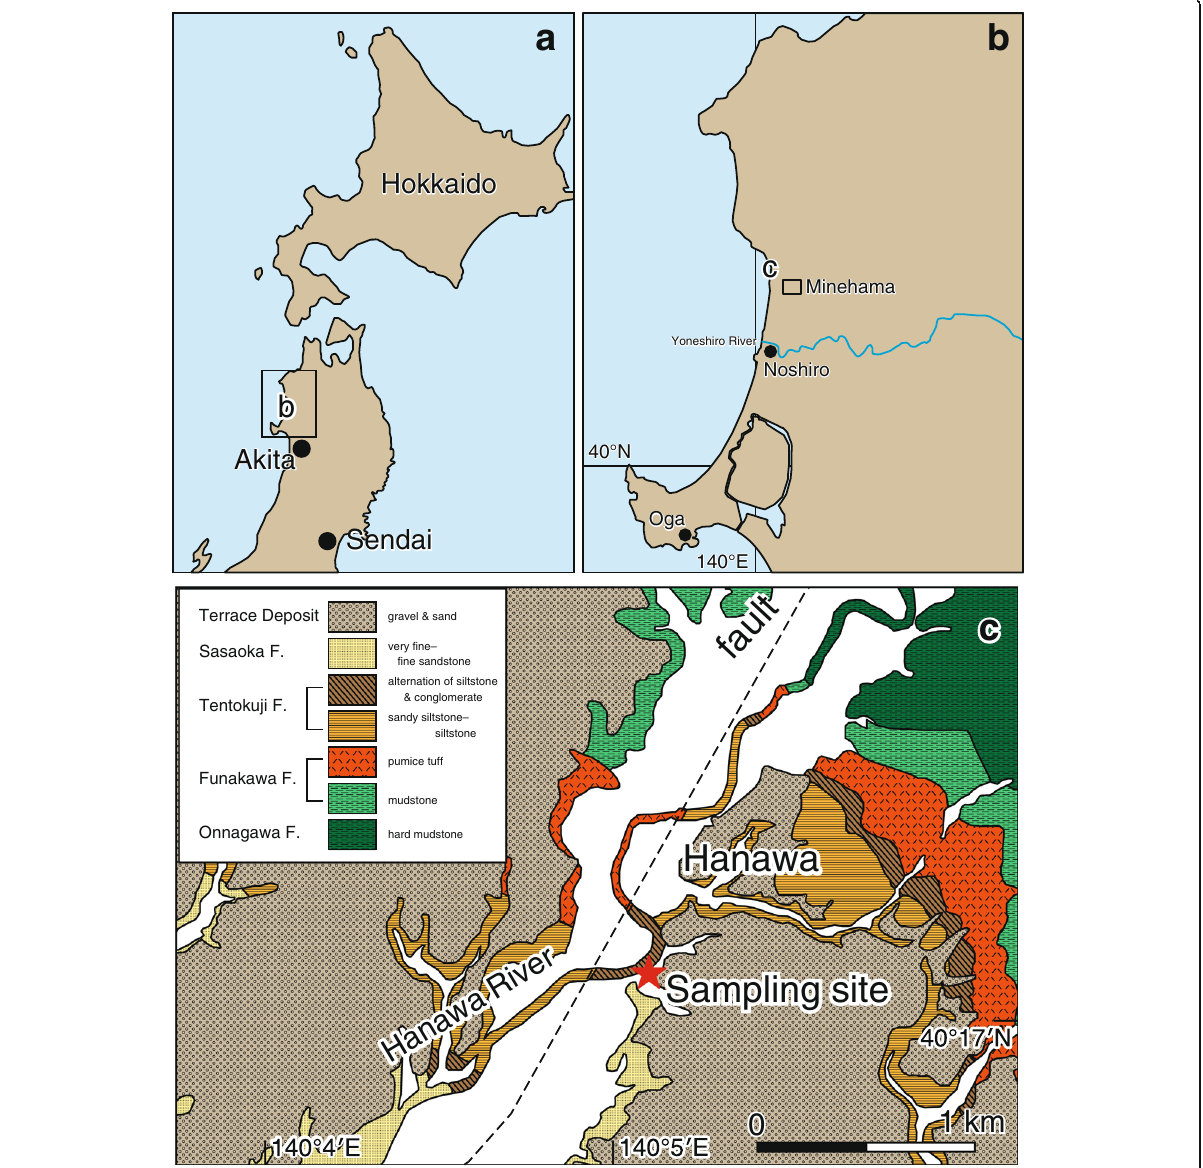
Fig. 2 Location and geologic map of the sample site. a Akita Prefecture, northeastern Japan. b Enlarged view of the square in a . c Geologic map of the Minehama area (modified from Sato et al. 2003). The red star indicates the site at which the fossil Terebratalia coreanica and Laqueus rubellus shells were